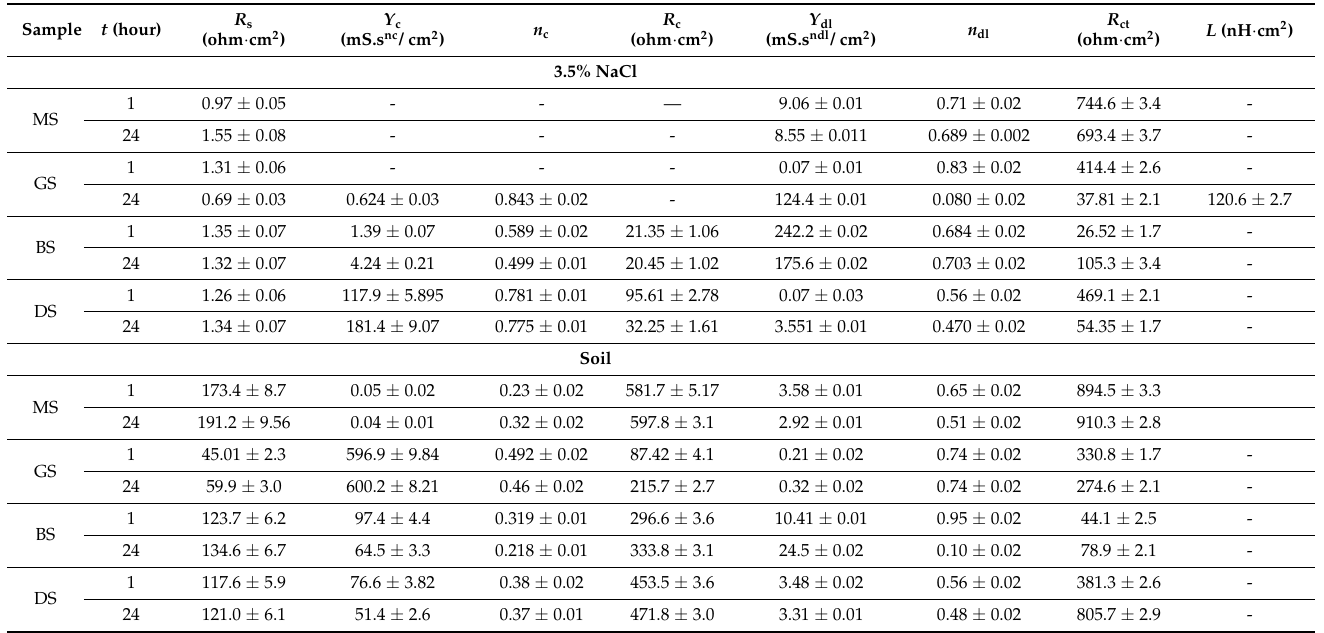
Figure 5. Equivalent electrical circuit models ( a ) Randle model, ( b ) effect of adsorption simulated by adding adsoption element ( Y ads ) in Randle circuit, ( c ) two time-constants in series, and ( d ) two time-constants in parallel combination were used to fit the experimental impedance spectra of MS and Zn electroplated and zinc-rich cold galvanized (ZRCG) coated samples. Table 2. Electrochemical parameters obtained from the fitting of experiment impedance